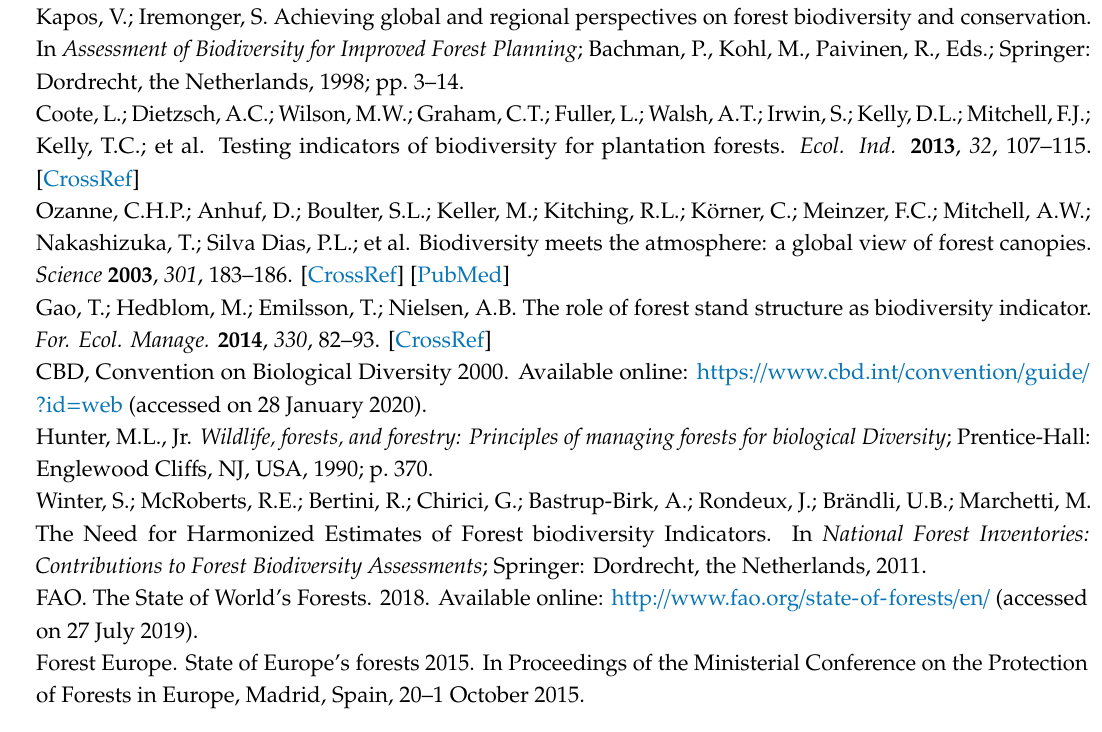
Table S1: Search strategy table; list of papers included in review / lists of papers excluded from the review; Table S2: Biodiversity attributes and indicators used in the literature sorted by type of biodiversity (structure, composition, function): Table S3: Correlations; File S1: